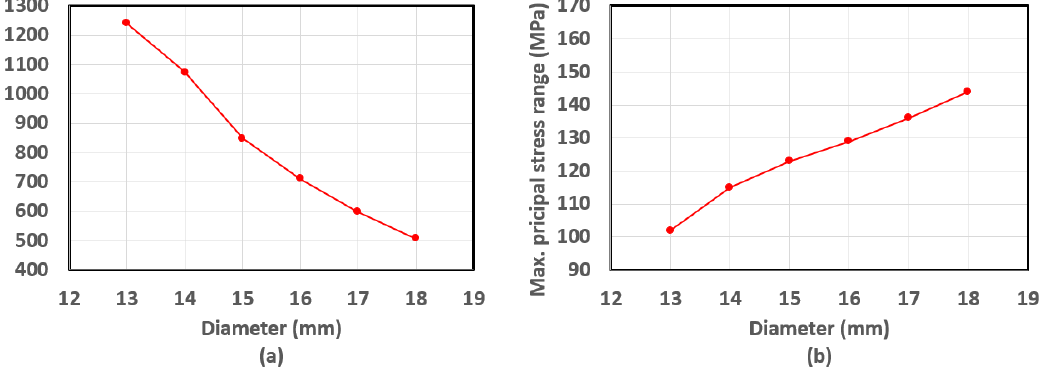
Figure 16. Stress variation with the spring diameter: ( a ) maximum principal stress; ( b ) maximum principal stress range.